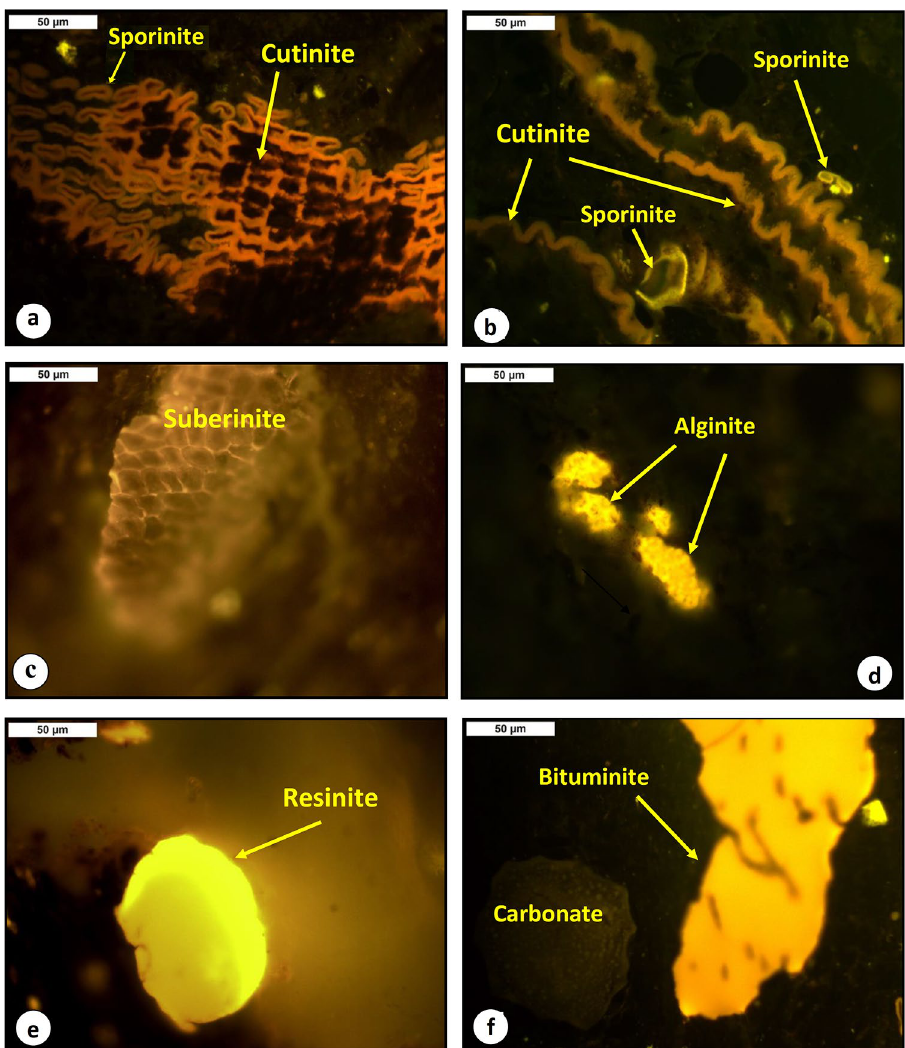
Fig. 4 Photomicrographs of organic matter assemblages from the analyzed bituminite shale rocks; under UV light, field width = 0.2 mm, includ- ing structured and unstructured fluorescence liptinite of sporin- ite, cutinite, alginite, resinite and bituminite,